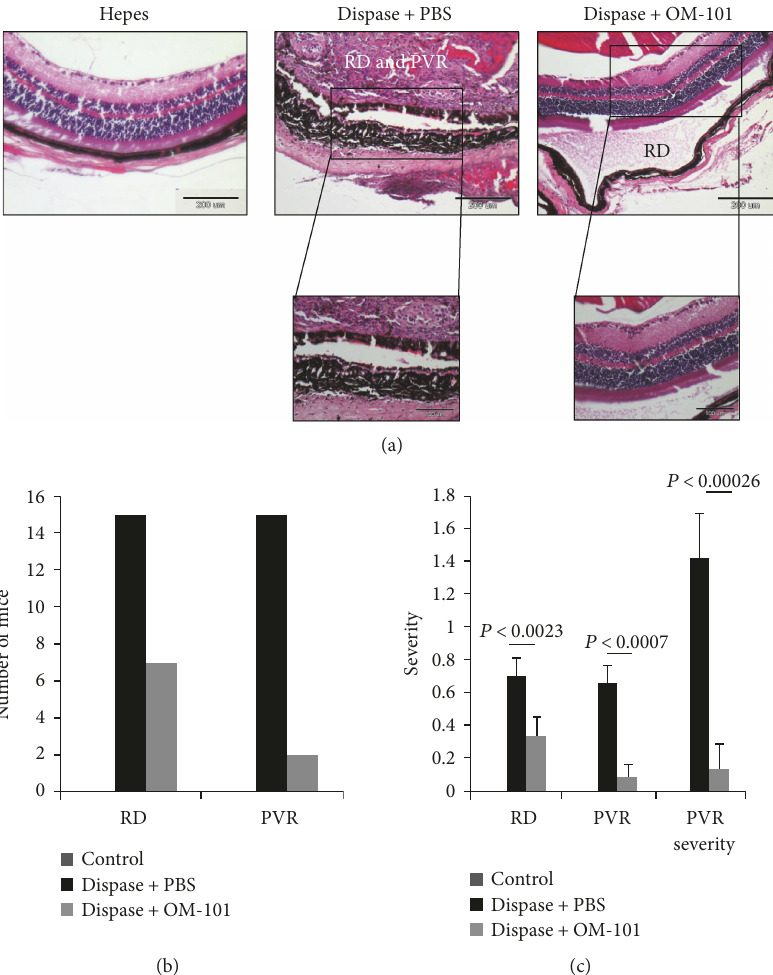
Figure 2: Histological staining (H&E) of induced RD and PVR in retina treated with OM-101. (a) Histological staining (H&E) demonstrated the following: left (control/Hepes), normal architecture; middle (dispase +PBS), abnormal morphology with in fl ammatory cells, fi broblasts, and pigment stain RPE cells through the retina denoting PVR; and right (dispase +OM 101), OM 101 treatment maintained the normal structure of the retina. Scale bar 100 μ m or 200 μ m. (b) Number of mice developing RD or PVR. (c) Severity score of the mice retina measured by thickness of the RD, number of in fl ammatory cells, loss of normal structure, and the appearance of RPE cells inside the retina ( N = 25 ). Statistics were computed using Student ’ s t -test (two-tailed distribution equal variance). Data is expressed as the mean ±